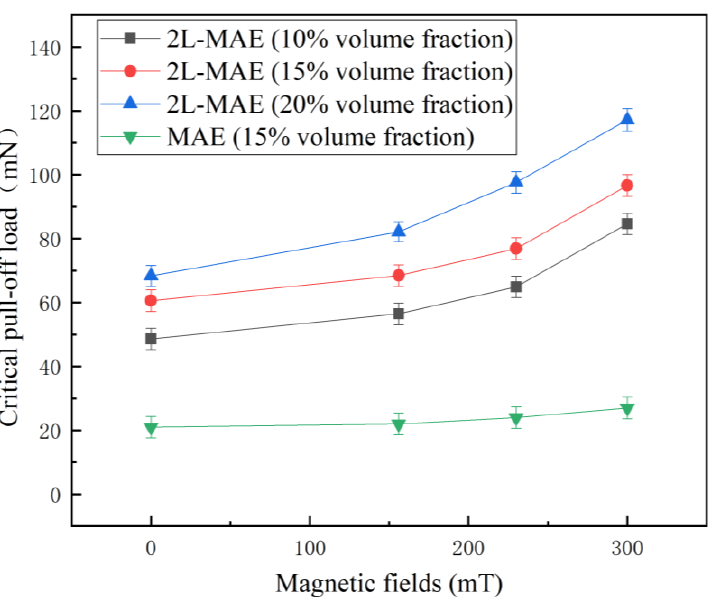
Figure 5. Critical pull-off load vs. external magnetic fields curves when the MAE samples detached from a dry acrylic substrate.